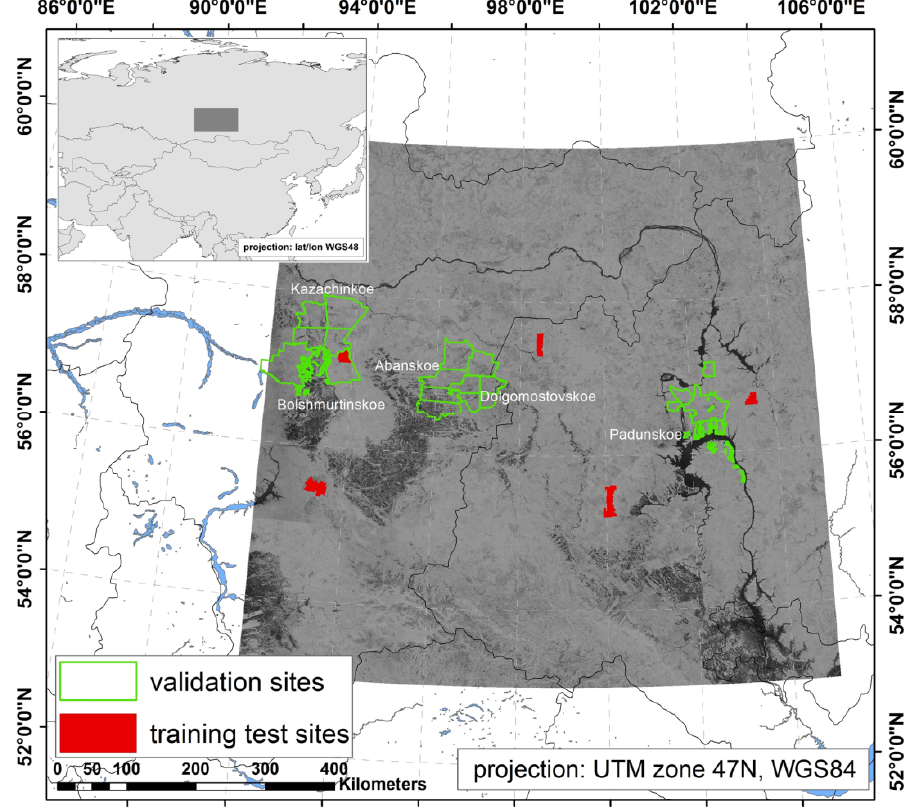
Figure 1. Location of the training and validation sites within the area covered by the mosaics. Upper left corner: Study area covered by the mosaics in a global